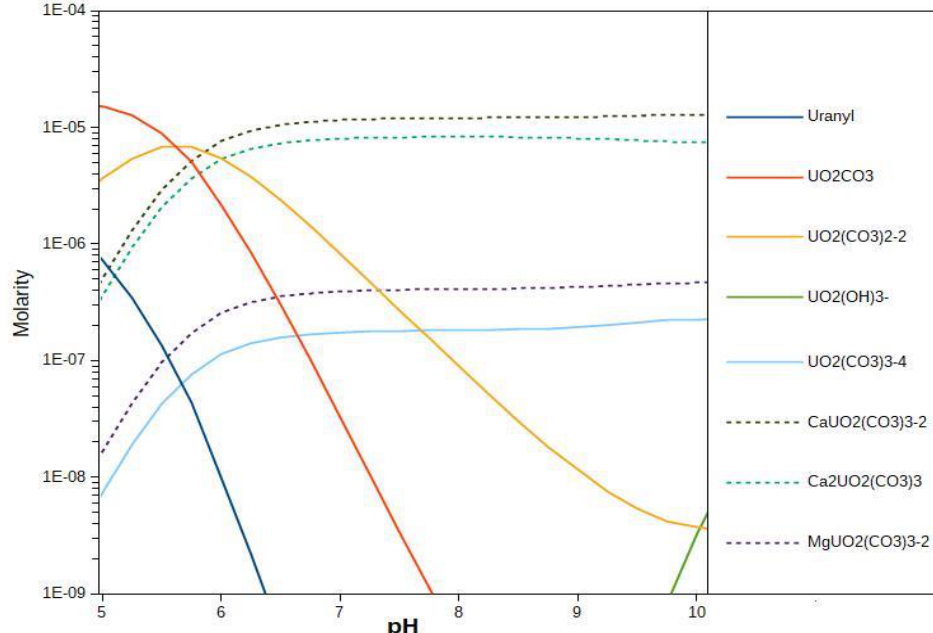
Figure A3. Distribution of uranium species, as a function of pH for the synthetic surface water (SSW) solution used in the batch sorption experiments.